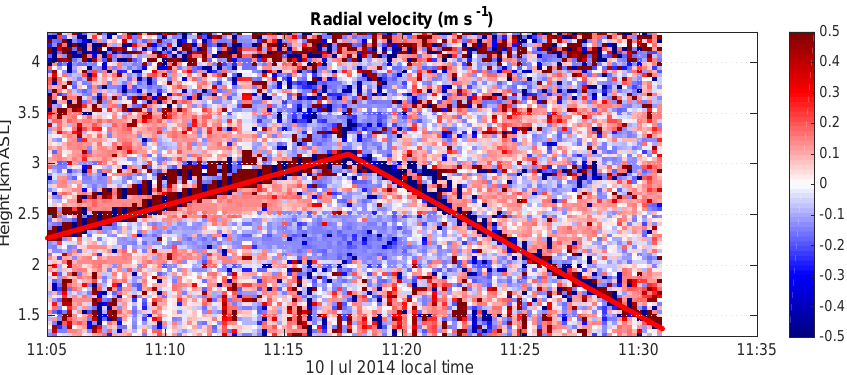
Figure 6. Corresponding radial velocity for the morning flight (same period as Fig. 5). The DataHawk trajectory is indicated by the red line. Vertical wind cannot be determined by the radar along the DH path due to strong returns from the DH